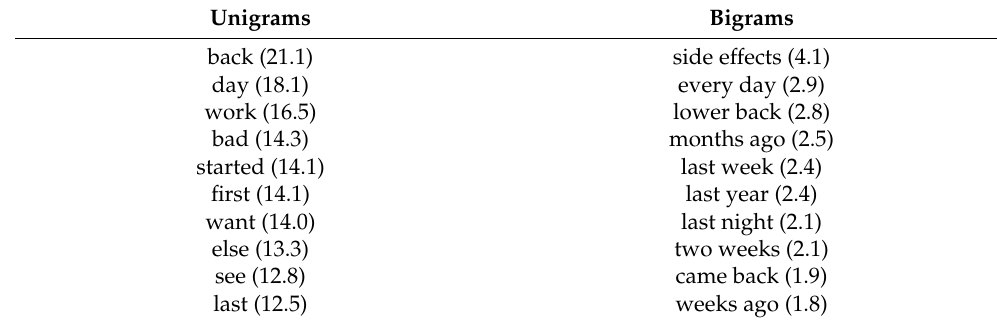
Table A2. Top 10 tokens with most corpus coverage, separated as unigrams and bigrams. Percentage is shown in parentheses.